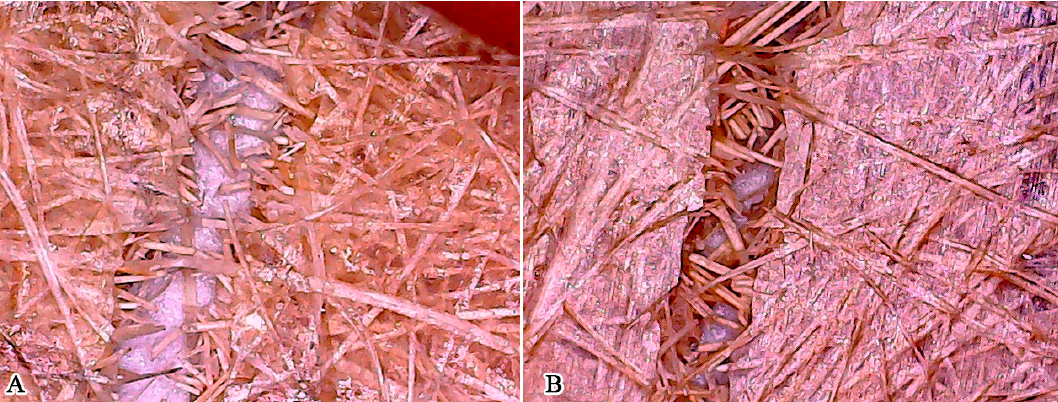
Figure 8. Tensile fractures of (a) polyester and (b) epoxy composites composed of treated fibres with Na